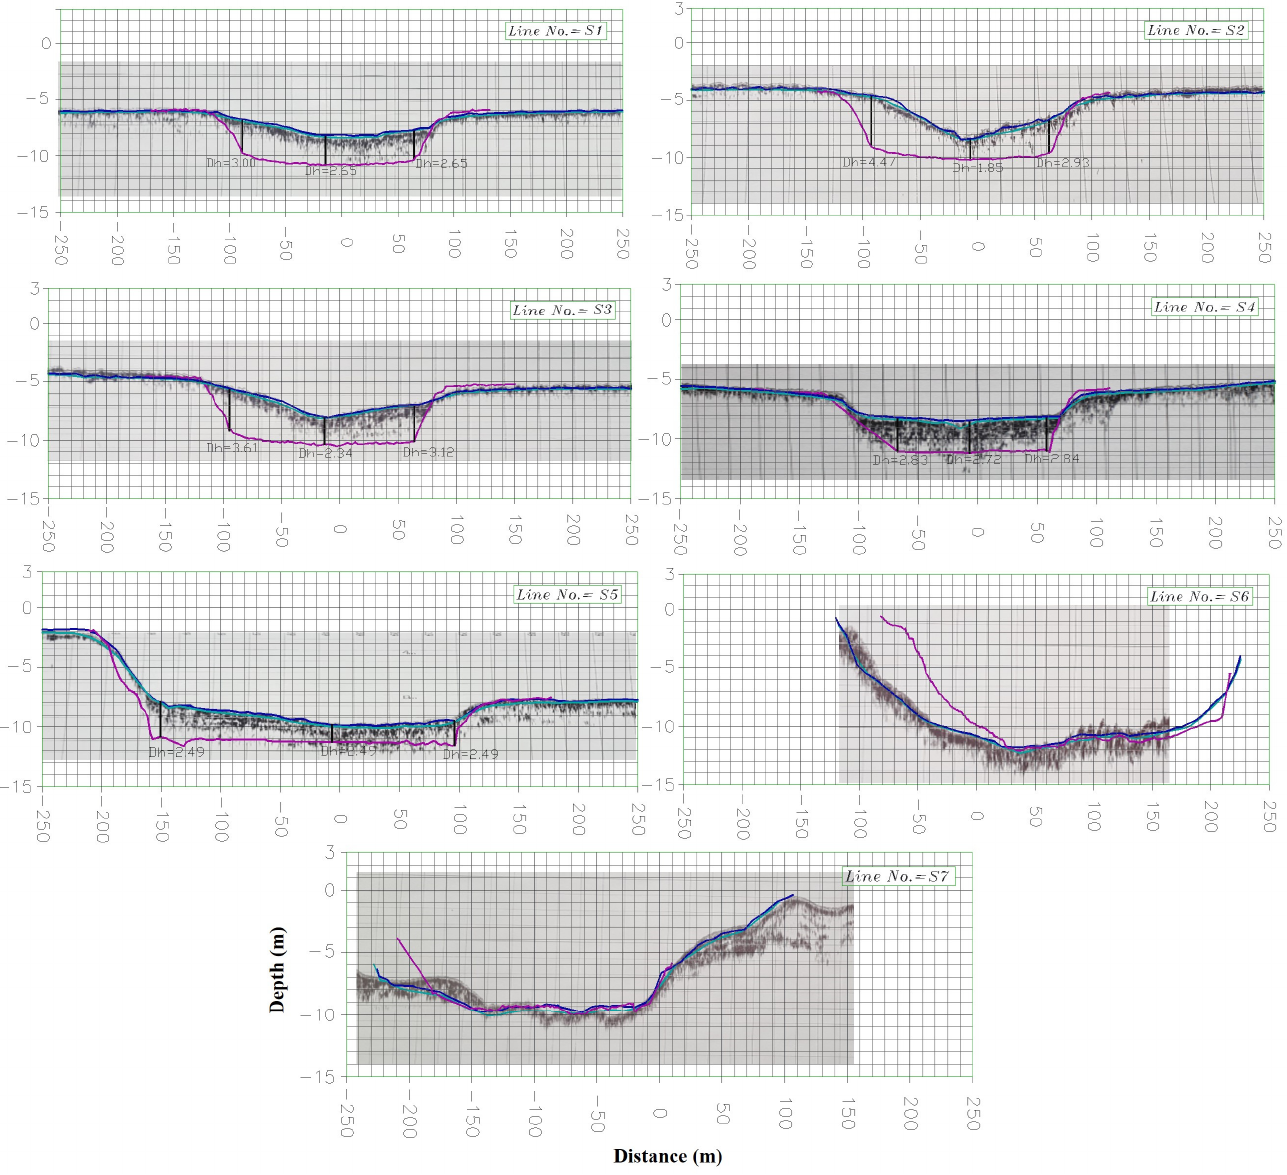
Figure 4. Digital depth profiles at the selected survey locations (7 transects; as depicted in Figure 2). The blue and cyan lines indicate the computed high- and low-frequency sounding depths, respectively, and the magenta line indicates the available bathymetric data in 2010.